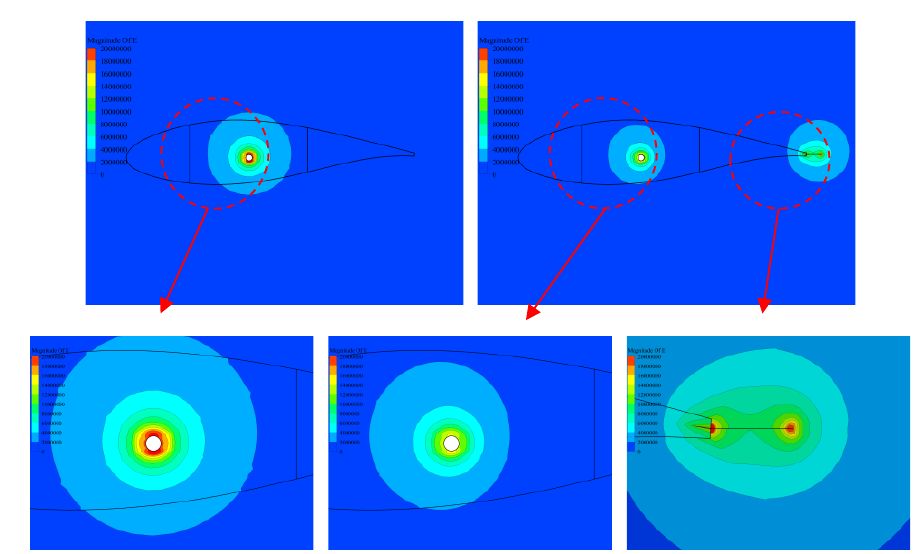
Figure 8. Cloud map of electric field intensity around the airfoil.